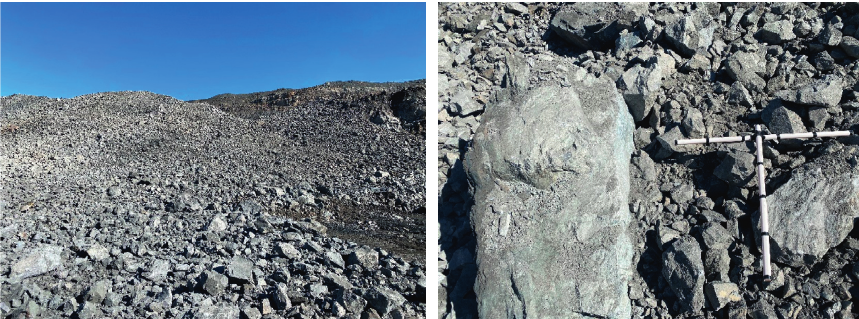
Figure 17: Effective stress of the section between the front holes at different times. Table 5: Comparison of blasting vibration